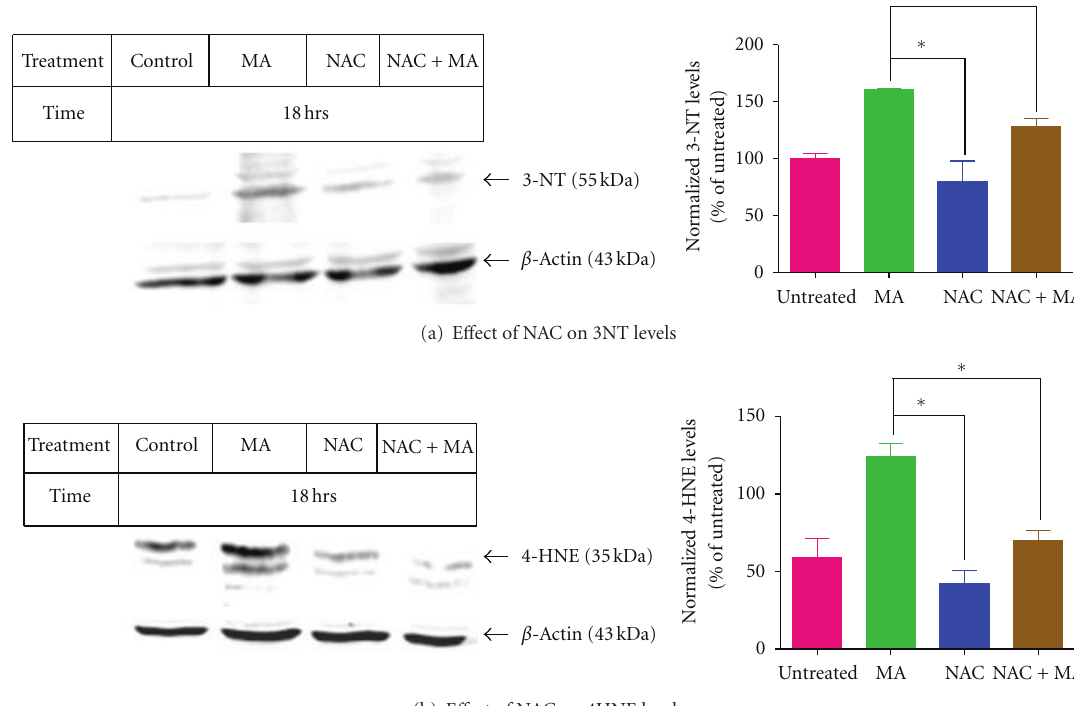
Figure 4: NAC attenuates markers of lipid and protein oxidative damage. (a) Western blot analysis of 3-NT detection and (b) Western blot analysis of 4-HNE detection in N27 dopaminergic neurons preincubated with 5mM NAC and treated with or without MA (2mM) for 18 hours. Equal loading of protein in each lane is confirmed by probing the membrane with β -actin antibody. Densitometry analysis of 3-NT and 4-HNE induction is represented next to the Western blot image. 3-NT and 4-HNE bands were quantified and expressed as percentage of untreated control. Data represent ± SEM, n = 2. ∗ P < 0 . 05 compared with MA-treated